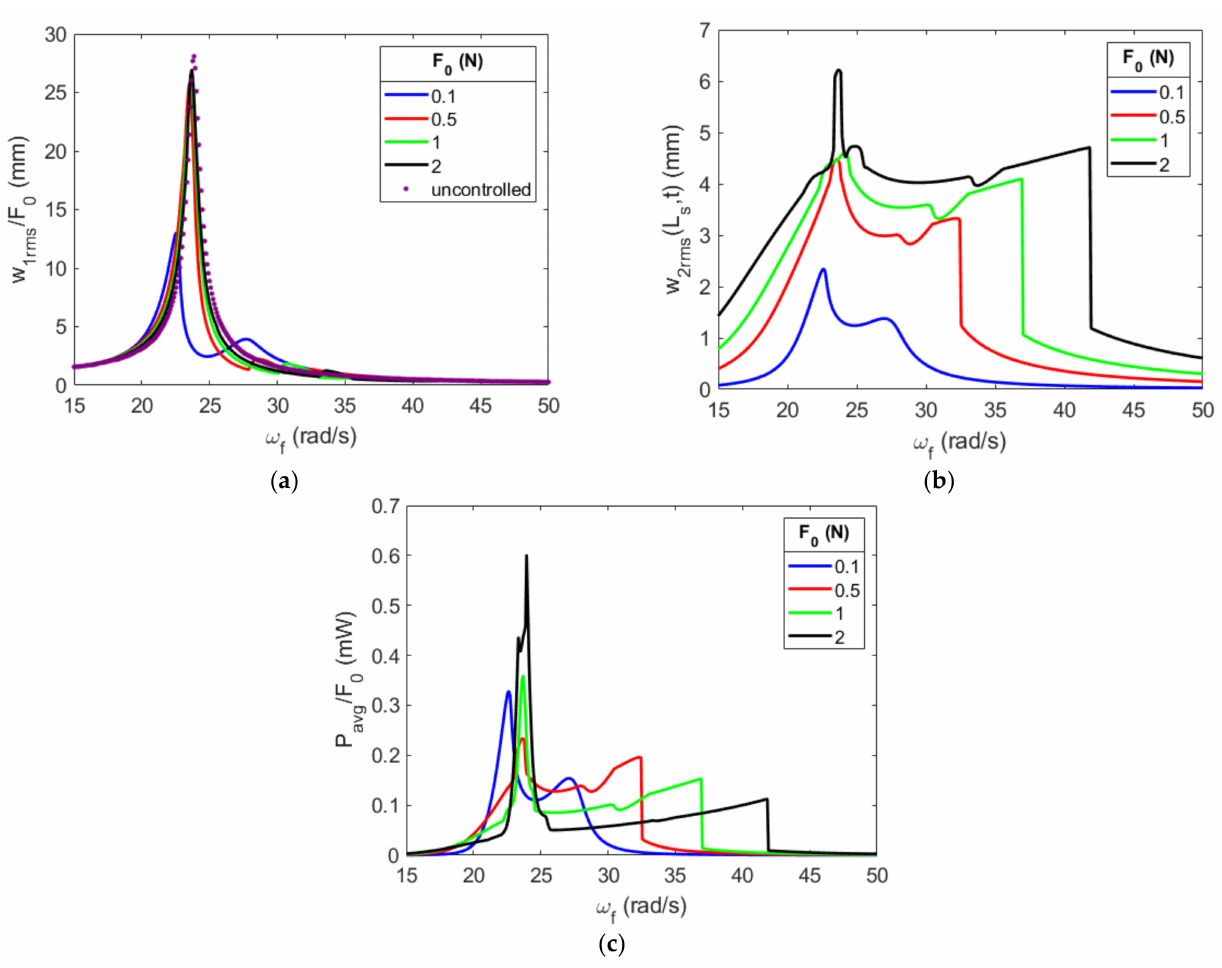
Figure 31. Forcing amplitude effects with a gap of 7.5 mm on the ( a ) primary structure’s normalized displacement, ( b ) the absorber’s displacement and ( c ) the normalized power